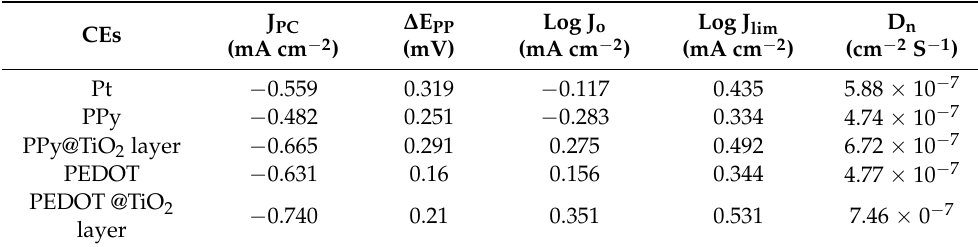
Table 1. CV, and Tafel parameters of the symmetric cells with various CEs and [Co(bpy) 3 ] 2+/3+ redox